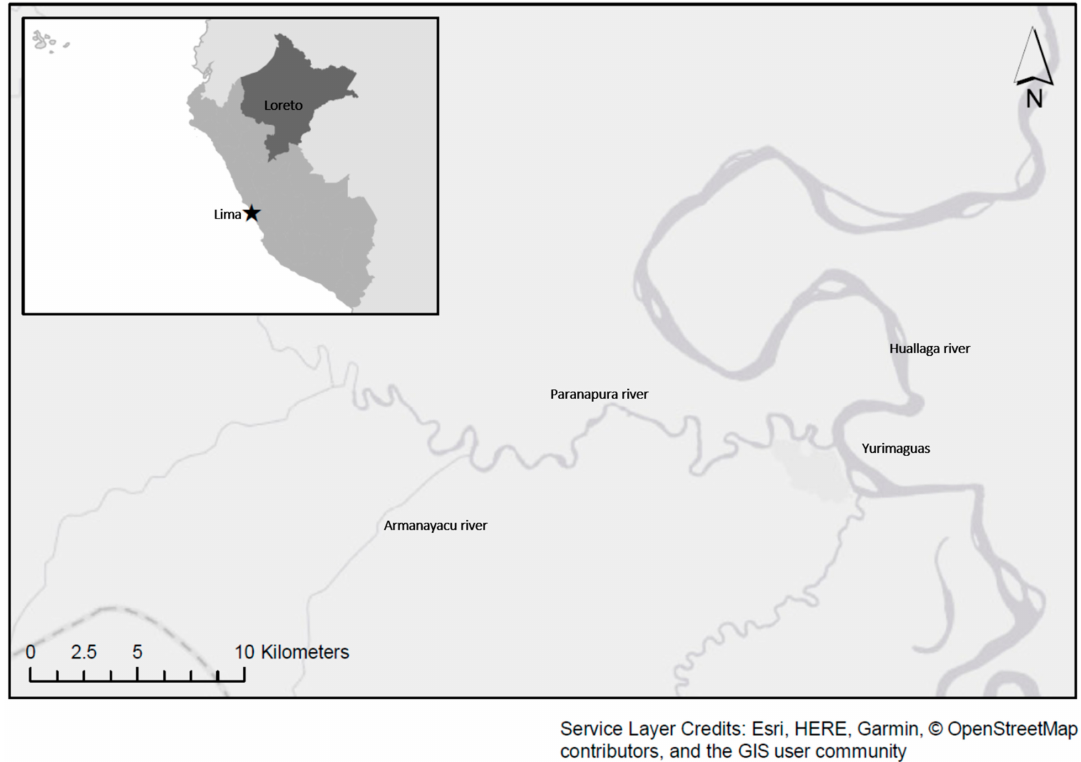
Figure 1. A map of Yurimaguas Armanayacu River and basin,